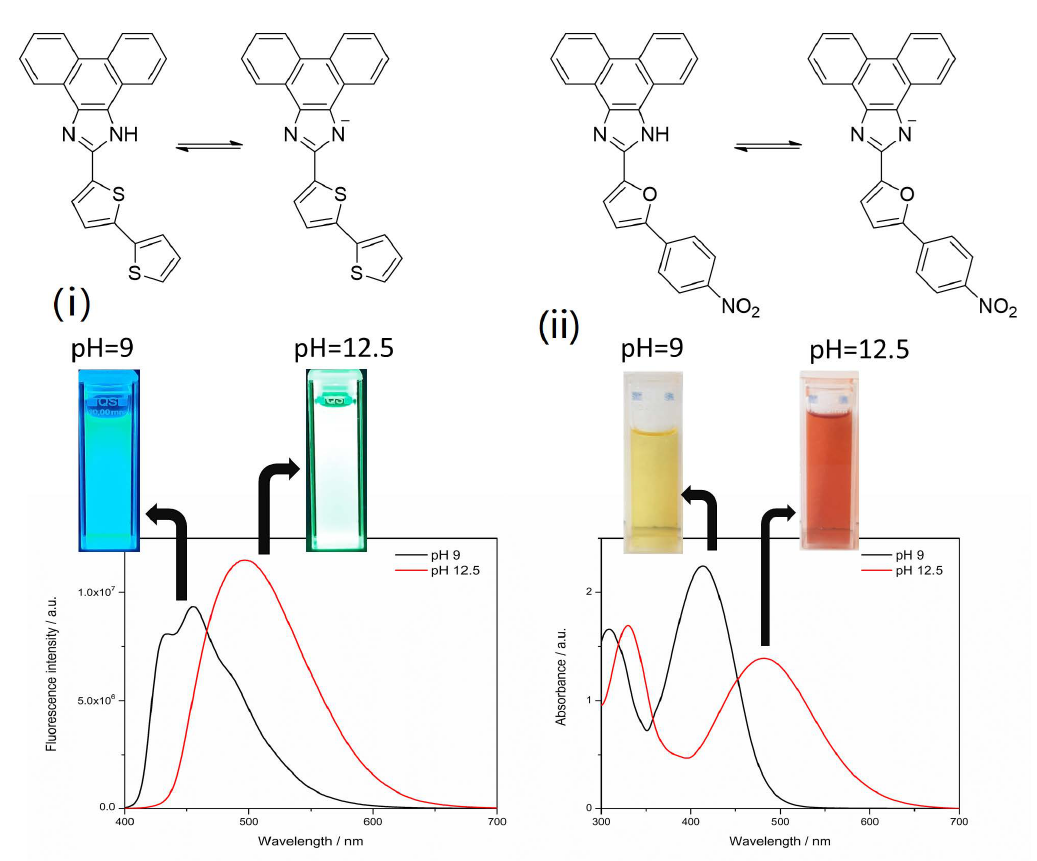
Figure 1. Structural changes and optical response of imidazole derivatives 3a , b in a commercial buffer solution of pH 9 and in SCPS at a pH of 12.5. 3a showed a bathochromic shift in the fluorescence spectra. 3b showed a bathochromic shift in the absorbance spectra. Fluorimetric response of: ( i ) 3a under a UV light (365 nm); ( ii ) colorimetric response of 3b